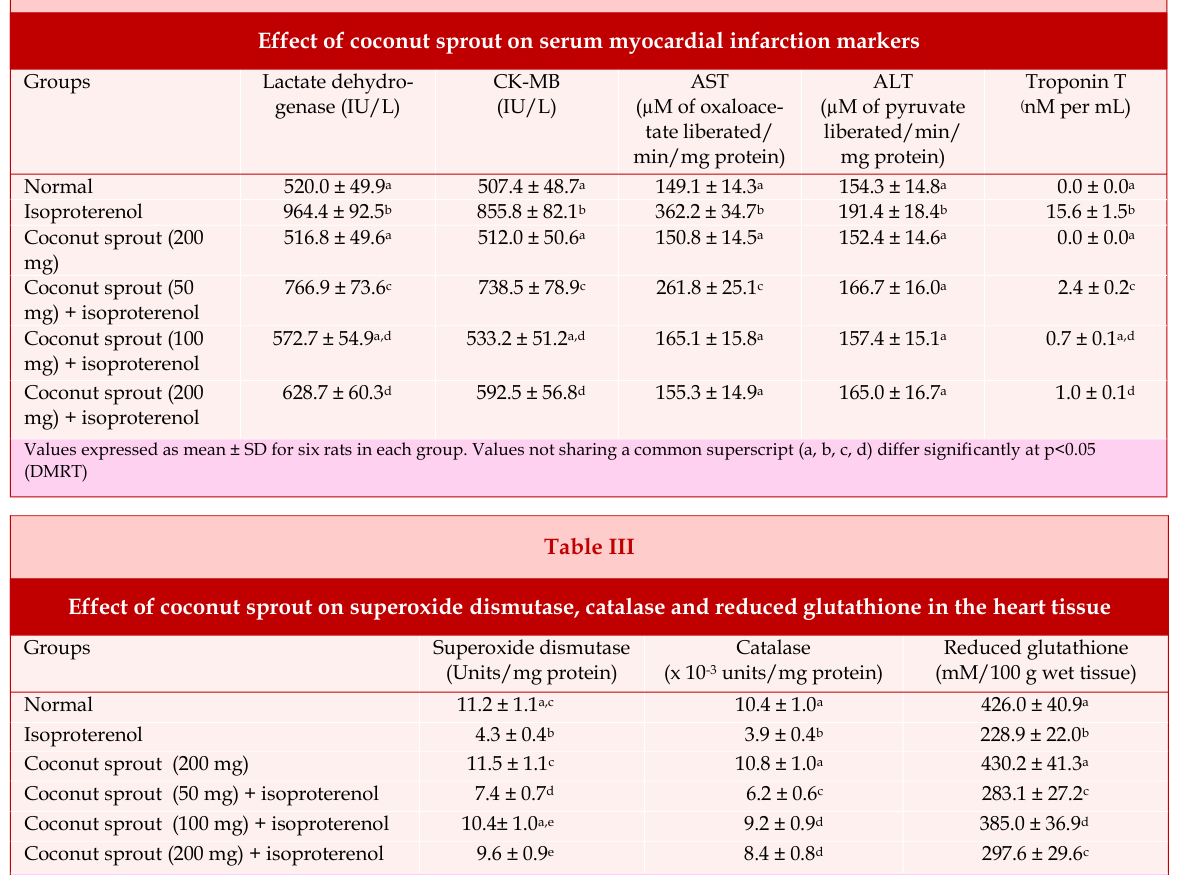
Effect of coconut sprout on serum myocardial infarction